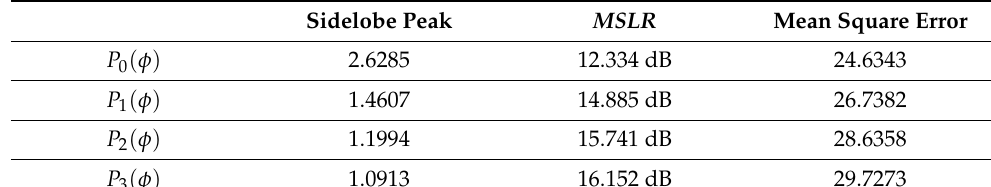
Table 1. Results of the cosine method for Example